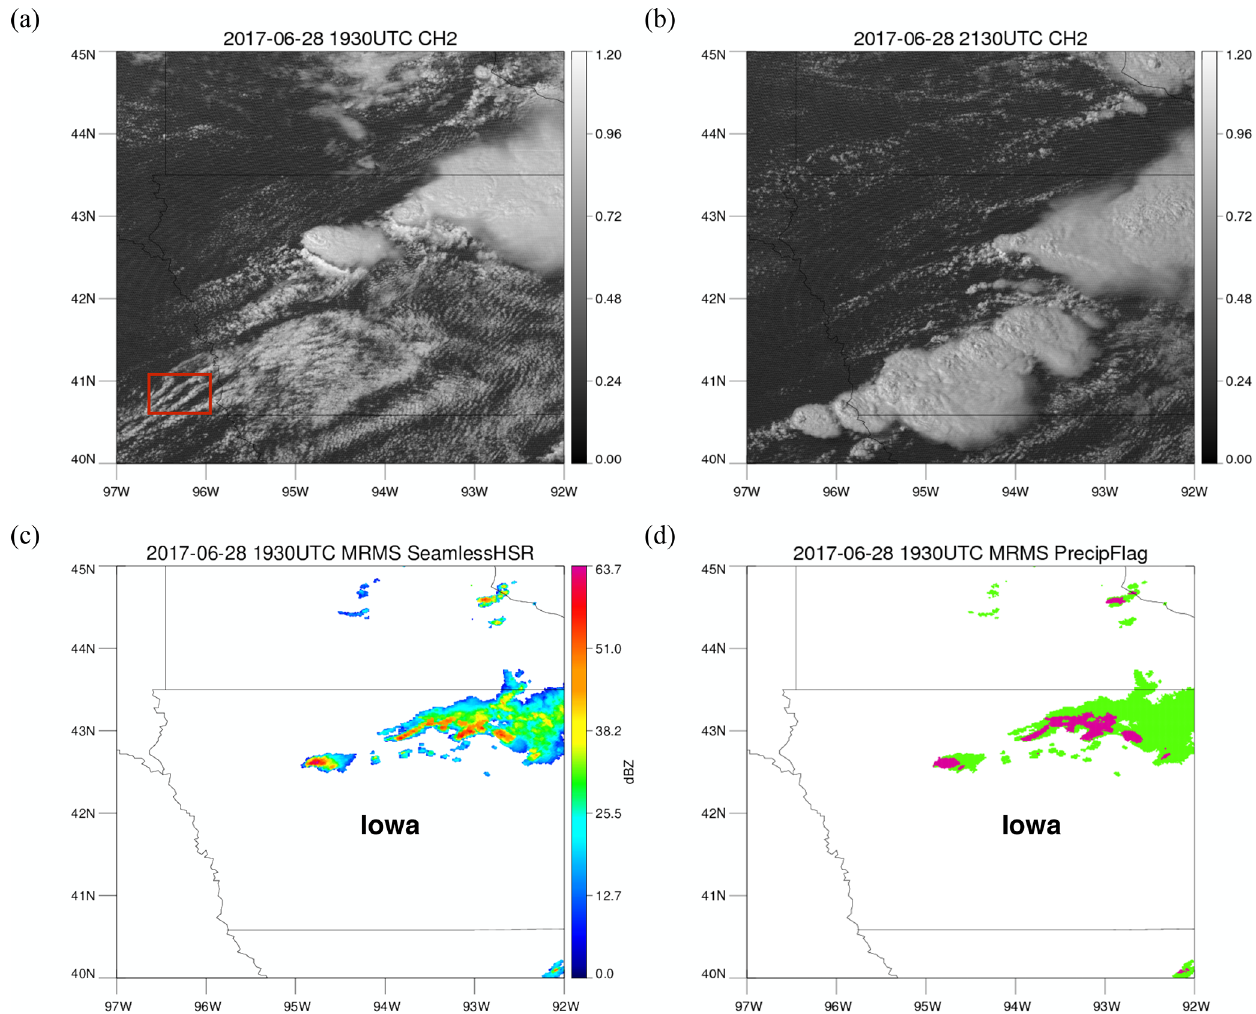
Figure 3. (a) GOES-ABI 0.65µm visible channel imagery (0.5km) at 19:30UTC on 28 June 2017 over Iowa. Numbers on the color bar rep- resent reflectances. The red box indicates regions where two convective cells are detected by the growing cloud detection method. (b) GOES- ABI 0.65µm visible channel imagery at 21:30UTC on 28 June 2017. (c) MRMS Seamless Hybrid Scan Reflectivity (SHSR) at 19:30UTC on 28 June 2017. (d) MRMS PrecipFlag at 19:30UTC 28 June 2017. Pink represents convective while green represents